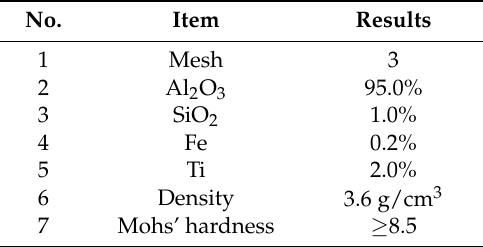
Figure 2. 3D morphology of the grit. Table 2. The detailed information on the grit.